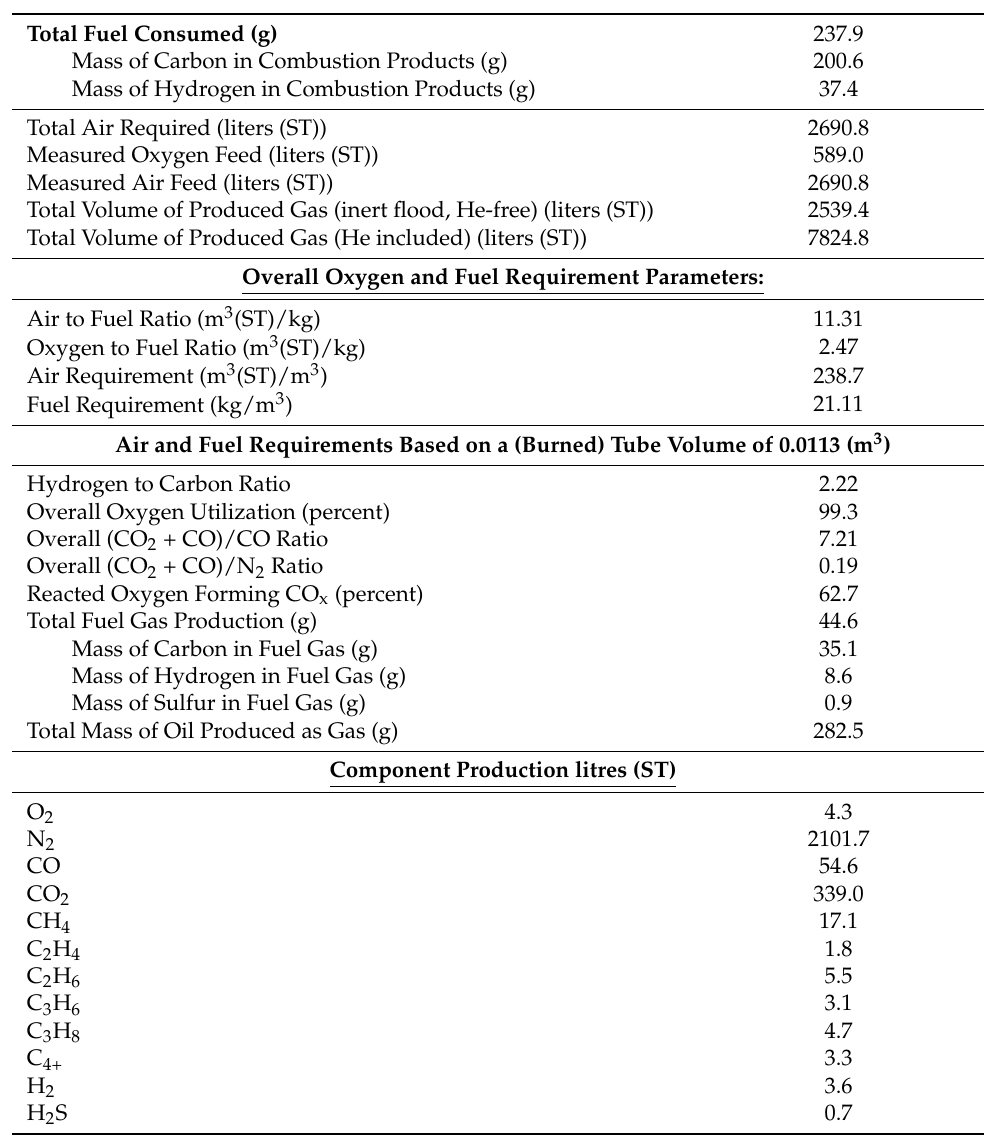
Table 6. Summary of ISC